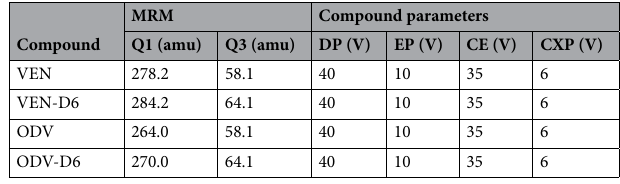
Table 4. Optimized MS parameters for MRM transitions of each